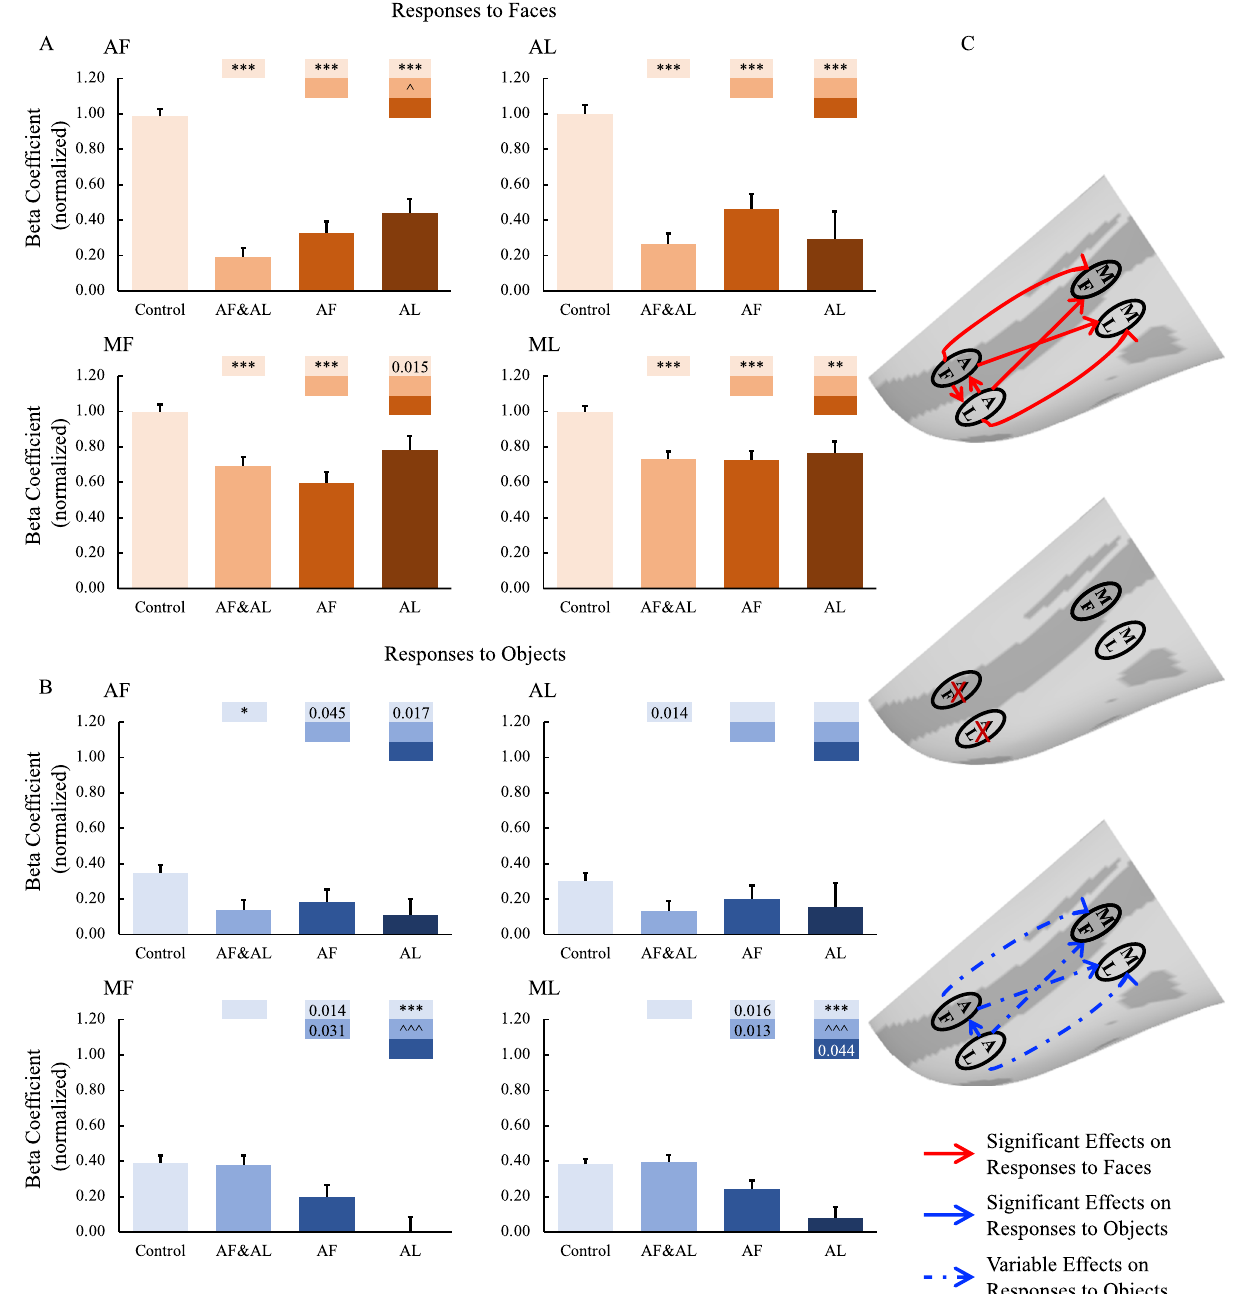
Fig.4|Effectsofanteriorfacepatchinactivationonresponsesintheipsilateral temporal face patches. A , B Effects of anterior face patch inactivation on responses to faces and objects in the temporal face patches in the hemisphere ipsilateral to theinactivation sitesacrossboth monkeys. Box plots displaymean values±SEM. The name of the ROI is shown at the top left of each panel. AF&AL: combined AF and AL inactivation; AF: AF alone inactivation; AL: AL alone inac- tivation. Generalized Linear Mixed Models were performed for each ROI (AF, MF, and ML: n =486; AL: n =336) with Treatment and Hemisphere as fi xed fac- tors, and Monkey (C and D), L-R hemisphere (Left and Right), Session, and Run as random factors. Post hoc testing was done with correction for multiple testing using the Holm-Bonferroni method. Color bars above a particular his- togram contain the statistical results of comparing this inactivation condition